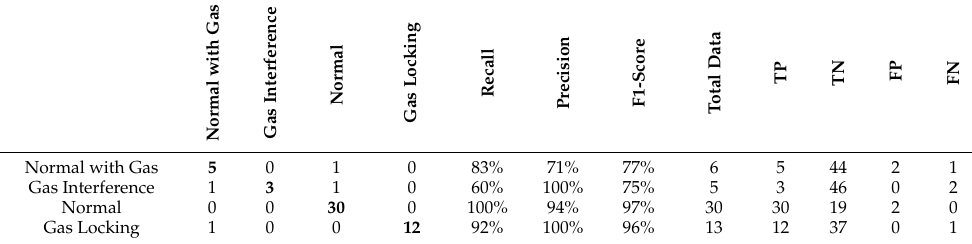
Table 7. Parameters of the Neural Network with hyperparameters and with unbalanced data.